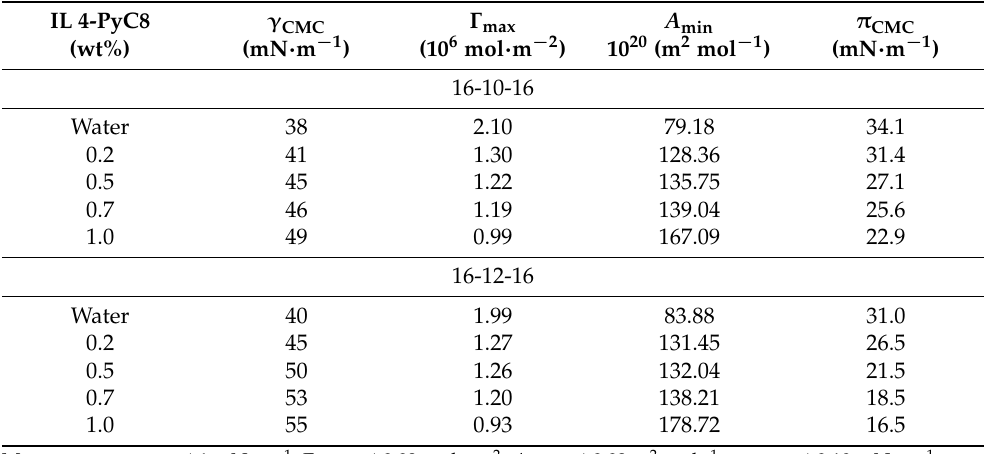
Table 2. Surface excess parameter ( Γ max ), surface pressure at CMC ( π CMC ) and minimum surface area per molecule ( A min ) of the studied gemini surfactants for different mass fractions of the IL 4-PyC8 at 300